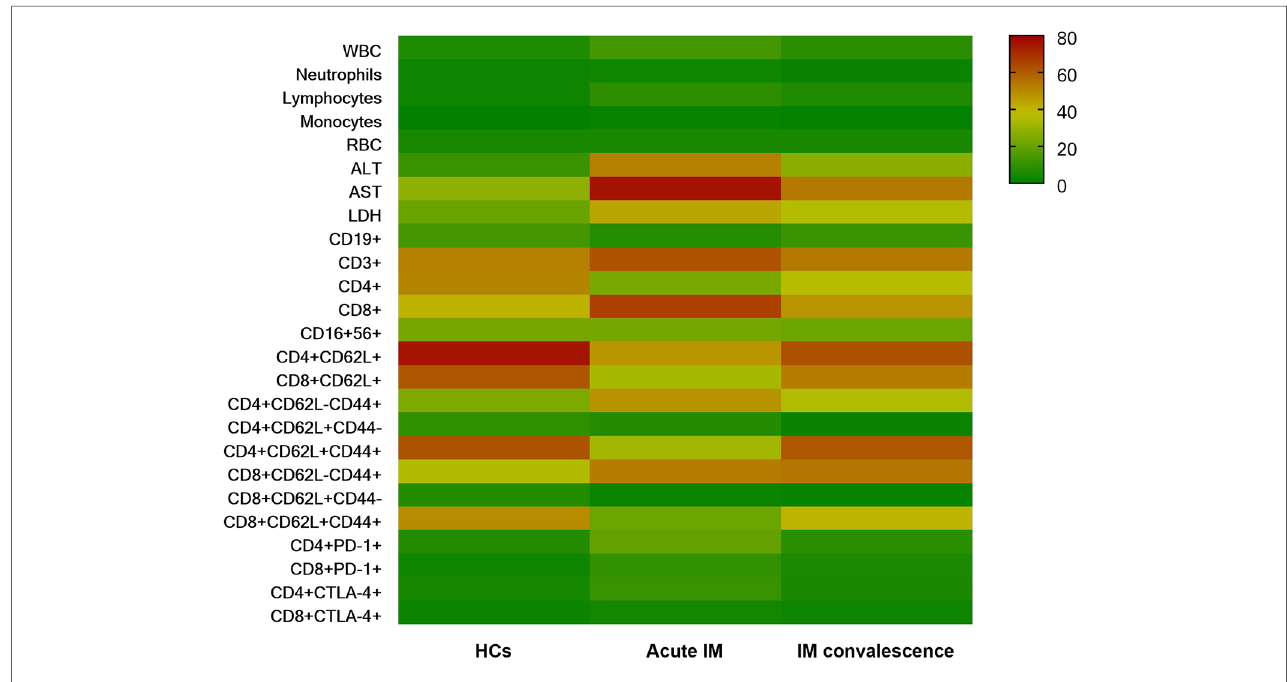
FIGURE 8 The overall characteristics of immunological events demonstrated by heatmap